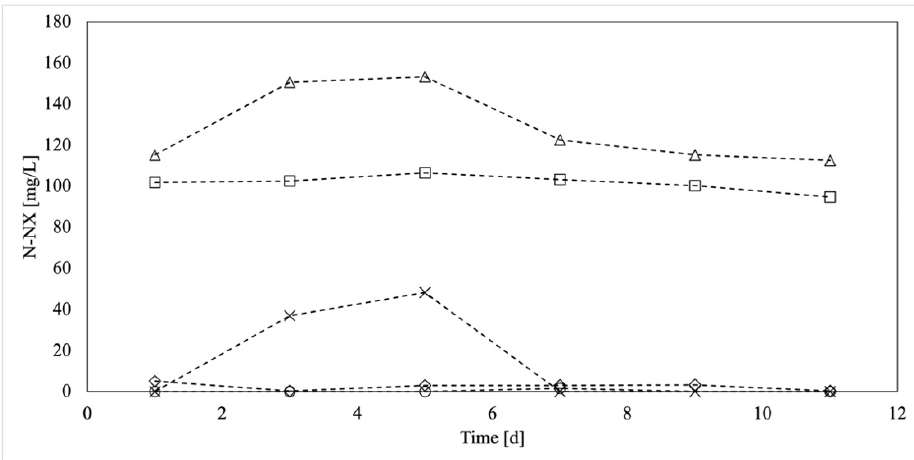
Figure 4. Evaluation of the Nitrification (NT) inoculum during the enrichment phase. N-NH 4+ influ- ent ( □ ), N-NH 4+ effluent ( ◊ ), N-NO 2- effluent ( ○ ), N-NO 3- influent (×), and N-NO 3- effluent ( ∆ ).